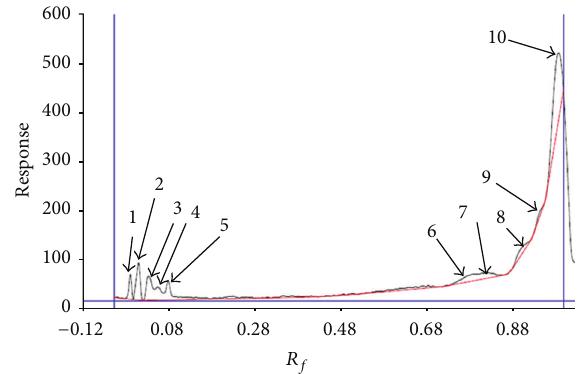
Figure 3: Chromatography of lipids in solvent system containing chloroform-methanol-water (60:10:1, v/v/v) scanned at 254nm using camag HPTLC scanner.